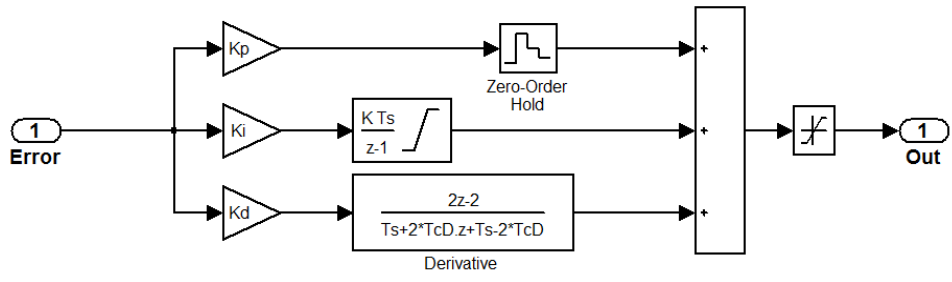
Figure 3. Simulink model of a conventional PID controller.